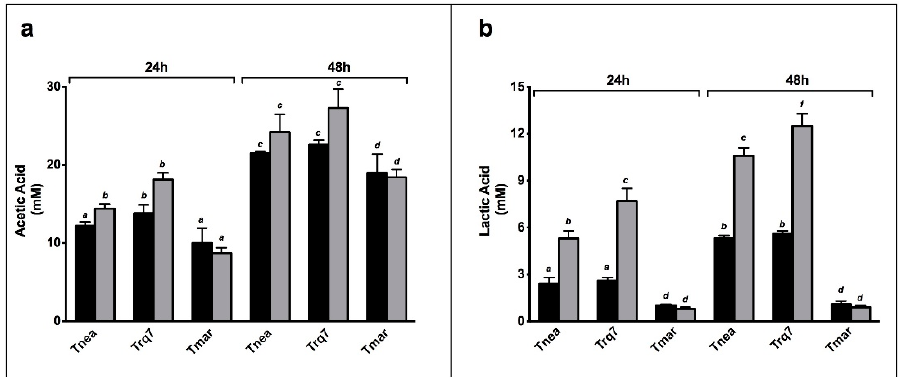
Figure 4. Acetic acid ( a ) and lactic acid ( b ) production under N 2 (black bars) and CO 2 (gray bars) conditions, at 24 and 48 h. Letters indicate ANOVA significances between treatments and species.